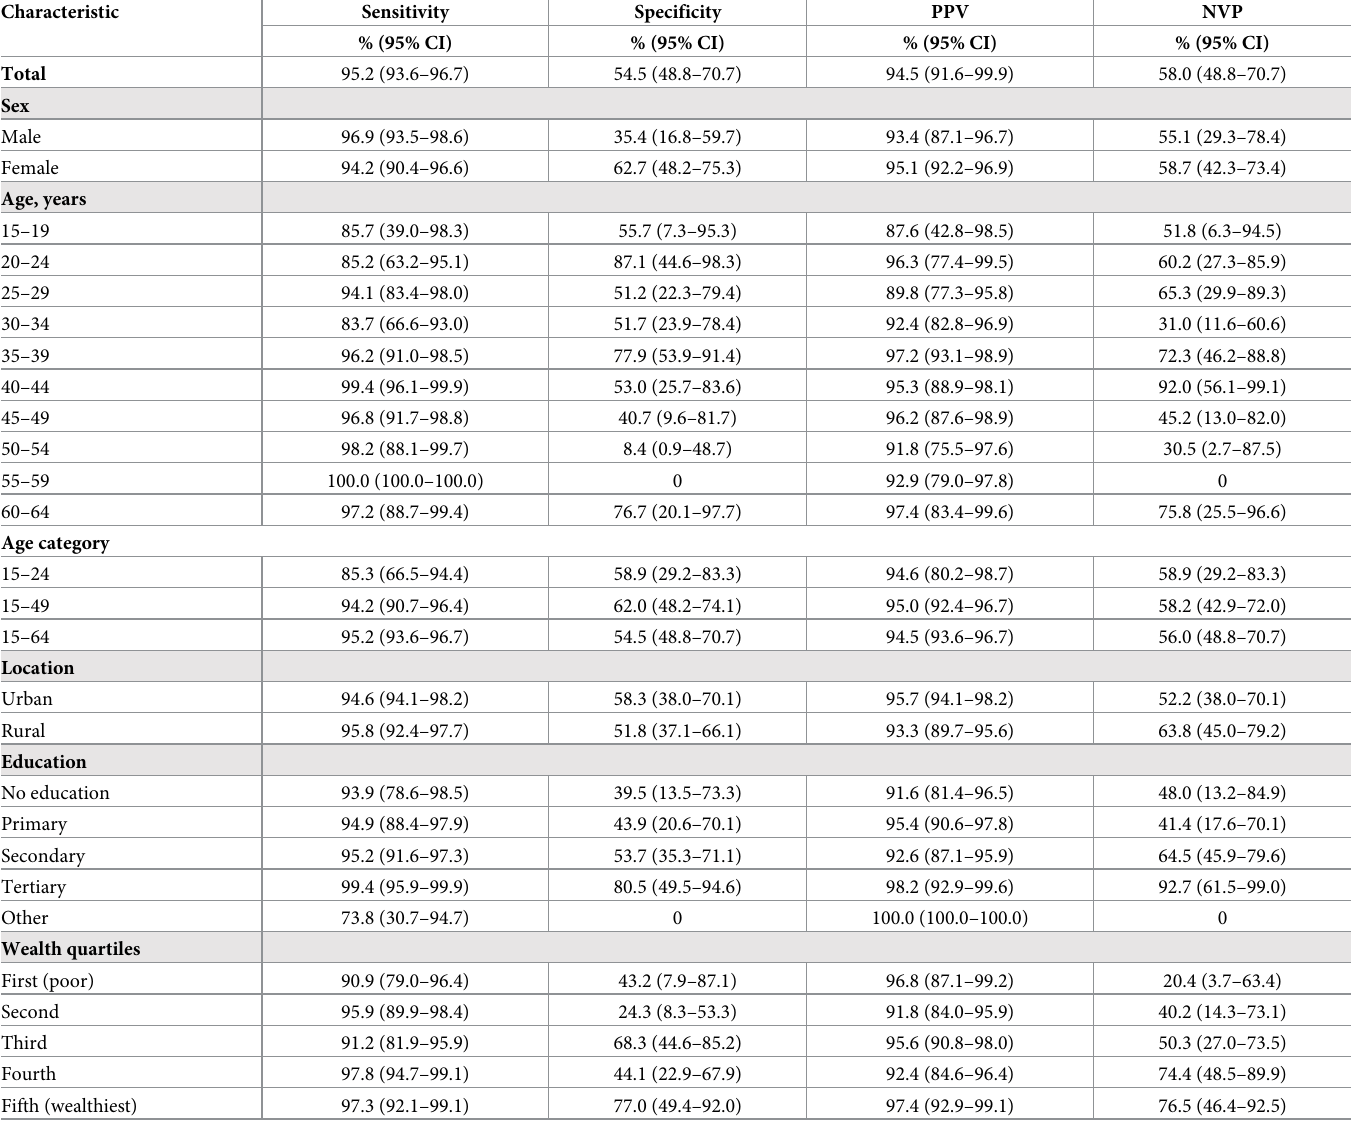
Table 4. Self-reported antiretroviral drug (ARV) use performance criteria (Nigeria HIV/AIDS and Indicator Survey